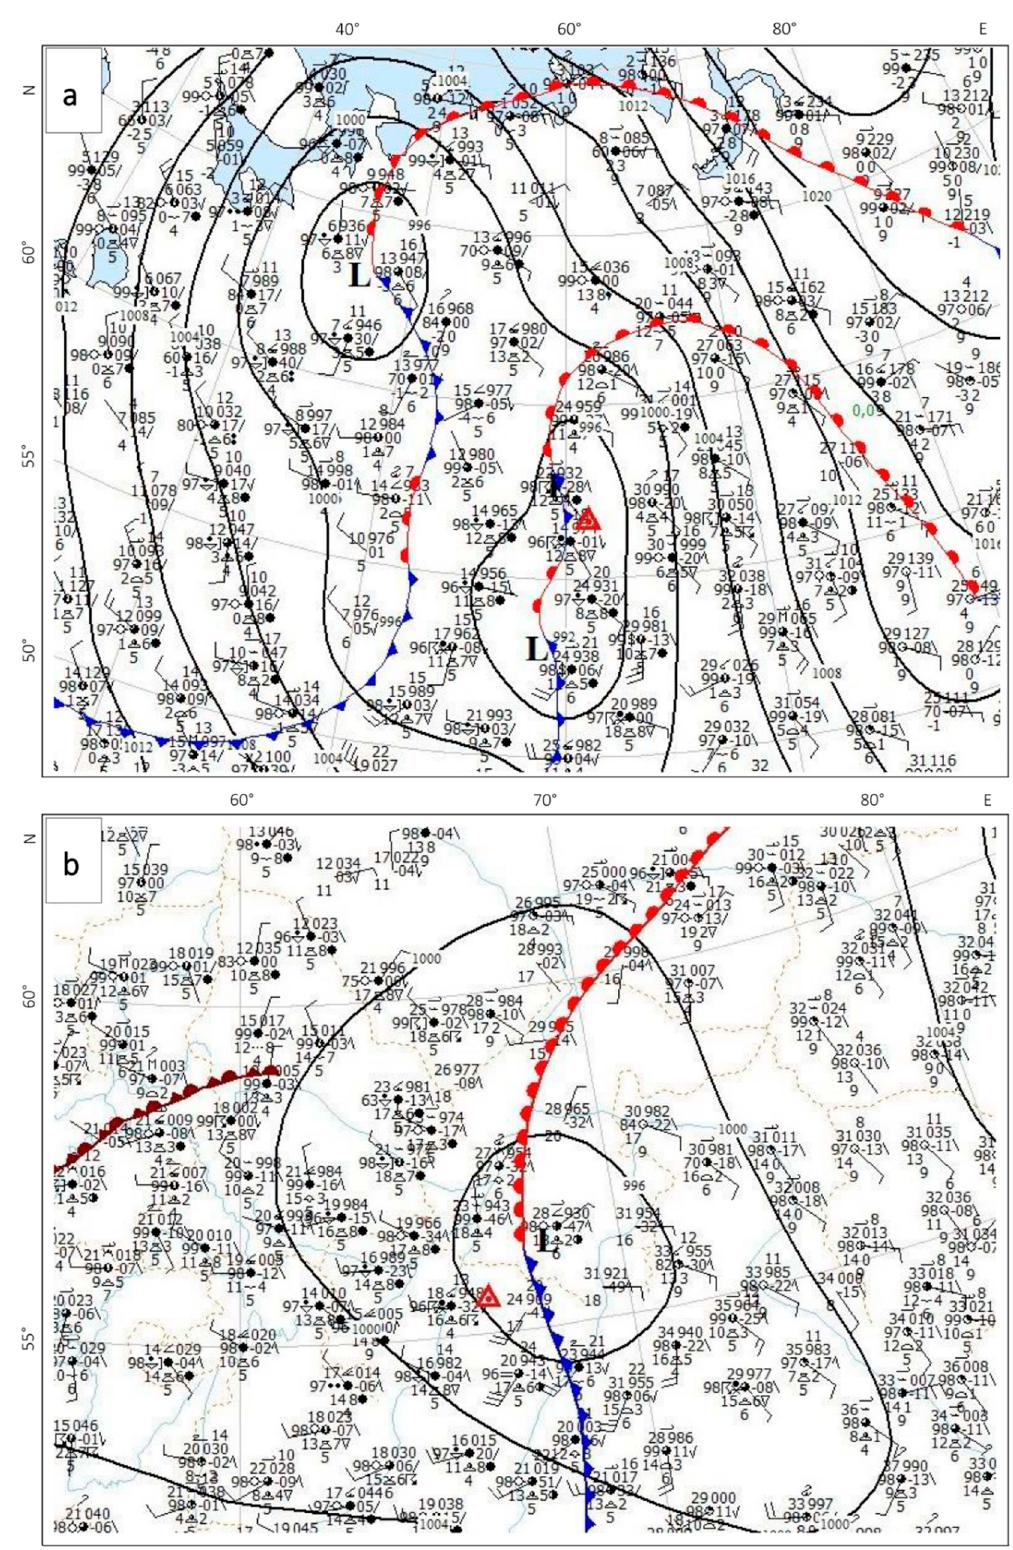
Figure 2. Surface synoptic charts for ( a ) 1200 UTC 3 June 2017 and ( b ) 1200 UTC 18 June 2017. Red triangles indicate the point with strongest tornado observed.